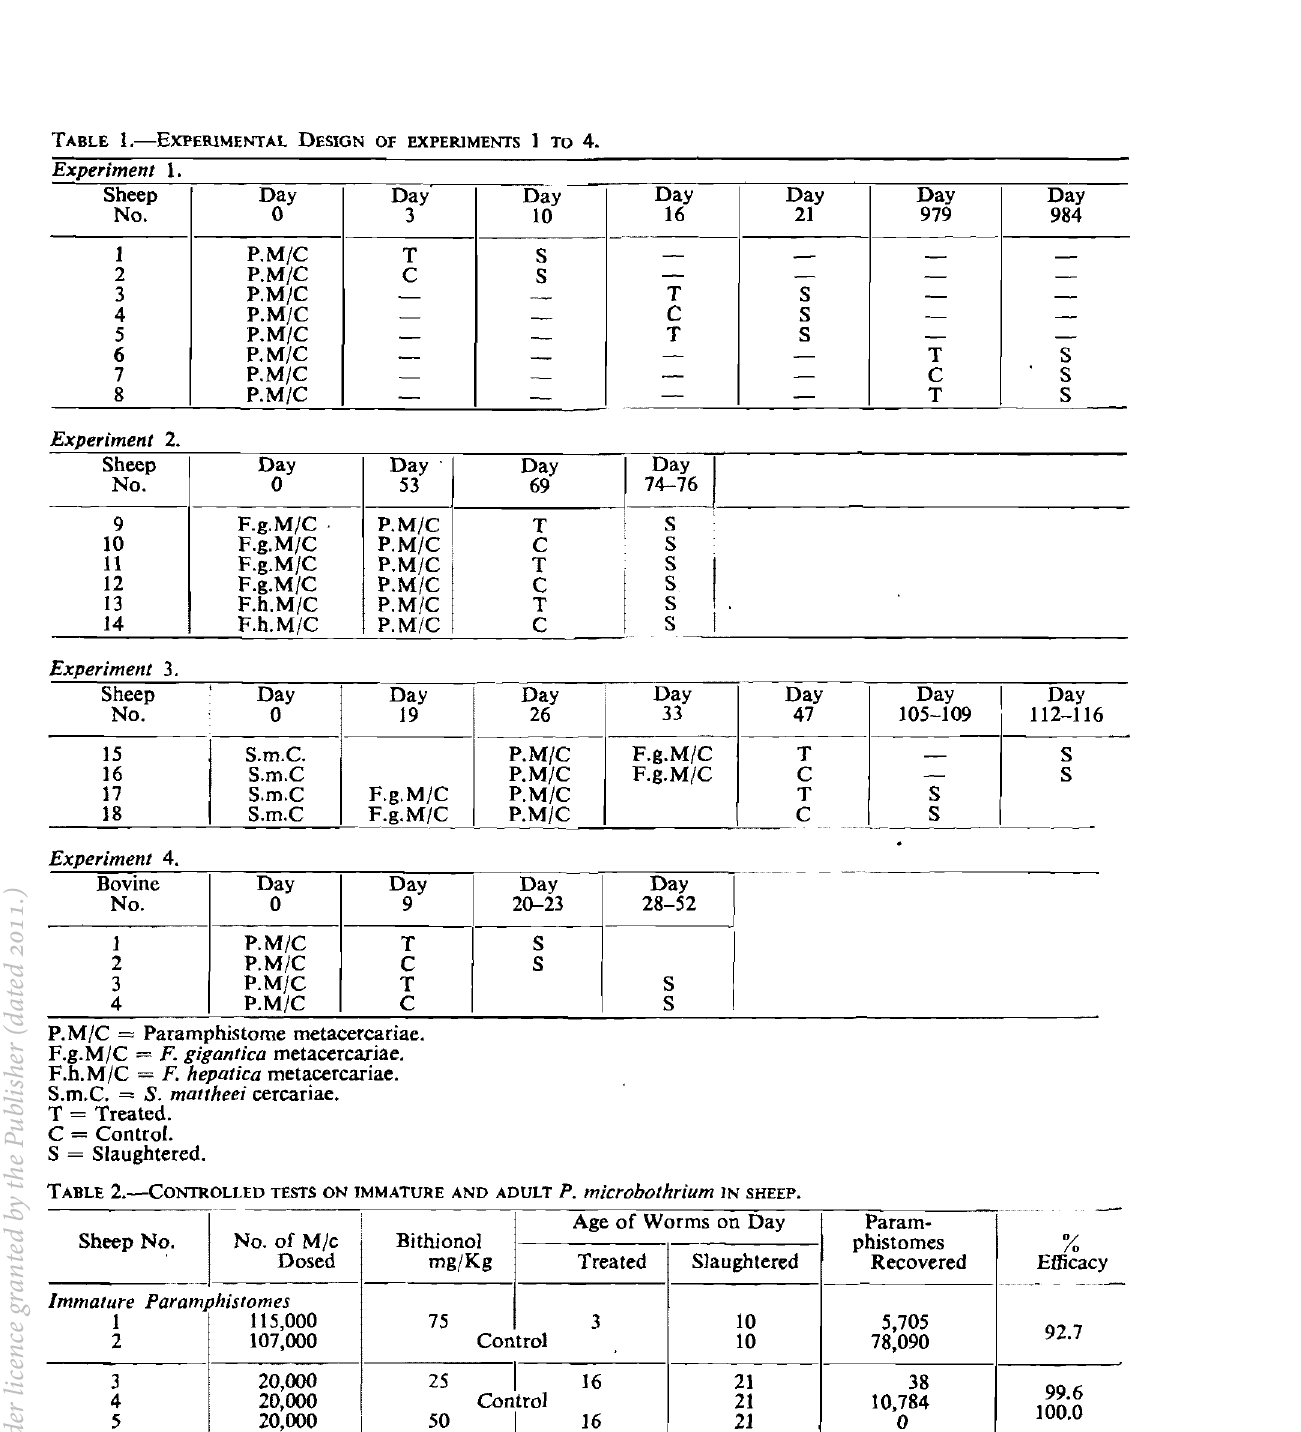
TABLE I.-EXPERIMENTAL DESIGN OF EXPERIMENTS I TO 4. Experiment 1.